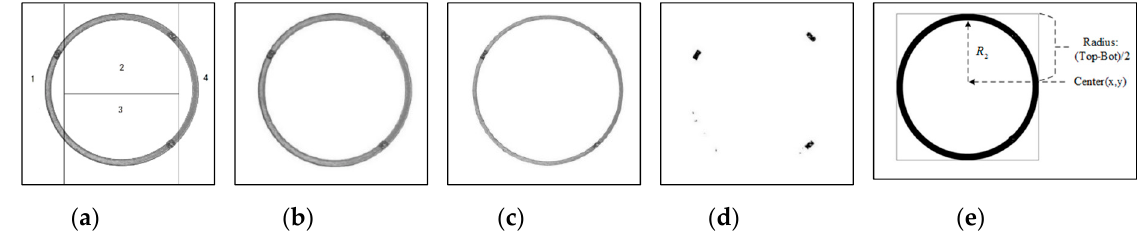
Figure 10. End face image processing: ( a ) segmentation of end face images; ( b ) end face image (2452 × 2056); ( c ) edge-removed end face image; ( d ) edge-removed end face binary image; ( e ) location result and annotation. Algorithm 1 Magnetic Ring Location Algorithm